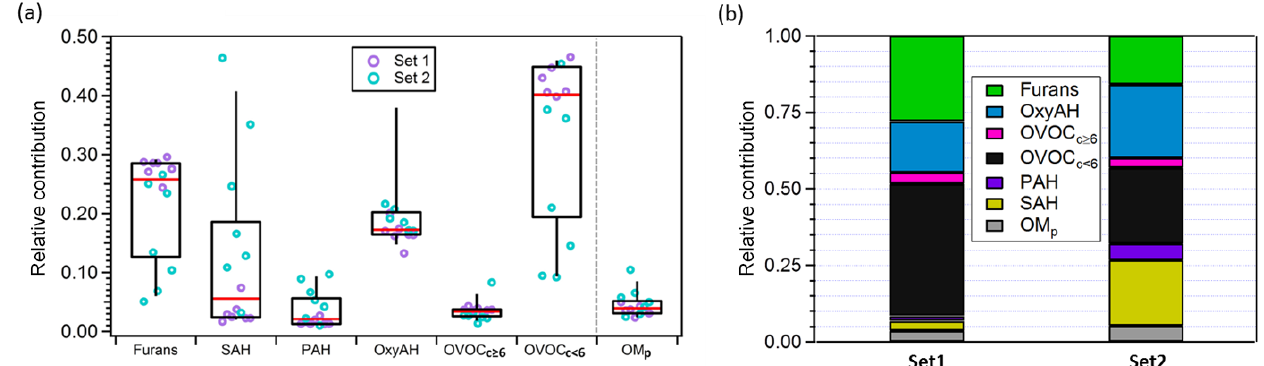
Figure 3. (a) Box plot for the relative contributions to the total primary emissions of the different precursor classes and of OM p averaged between experiments. OM p is the total semi-volatile and low-volatility organic matter calculated by means of the VBS model assuming the volatility distribution from May et al. (2013) and using as input the measured organic aerosol (OA) mass. The top and bottom whiskers represent the 90th and 10th percentiles, respectively, while the top, middle and bottom lines of the boxes show the 75th, 50th and 25th percentiles, respectively. The circles represent each single experiment from the two datasets investigated. (b) Average contributions of different precursor families and OM p for Set 1 and Set 2.